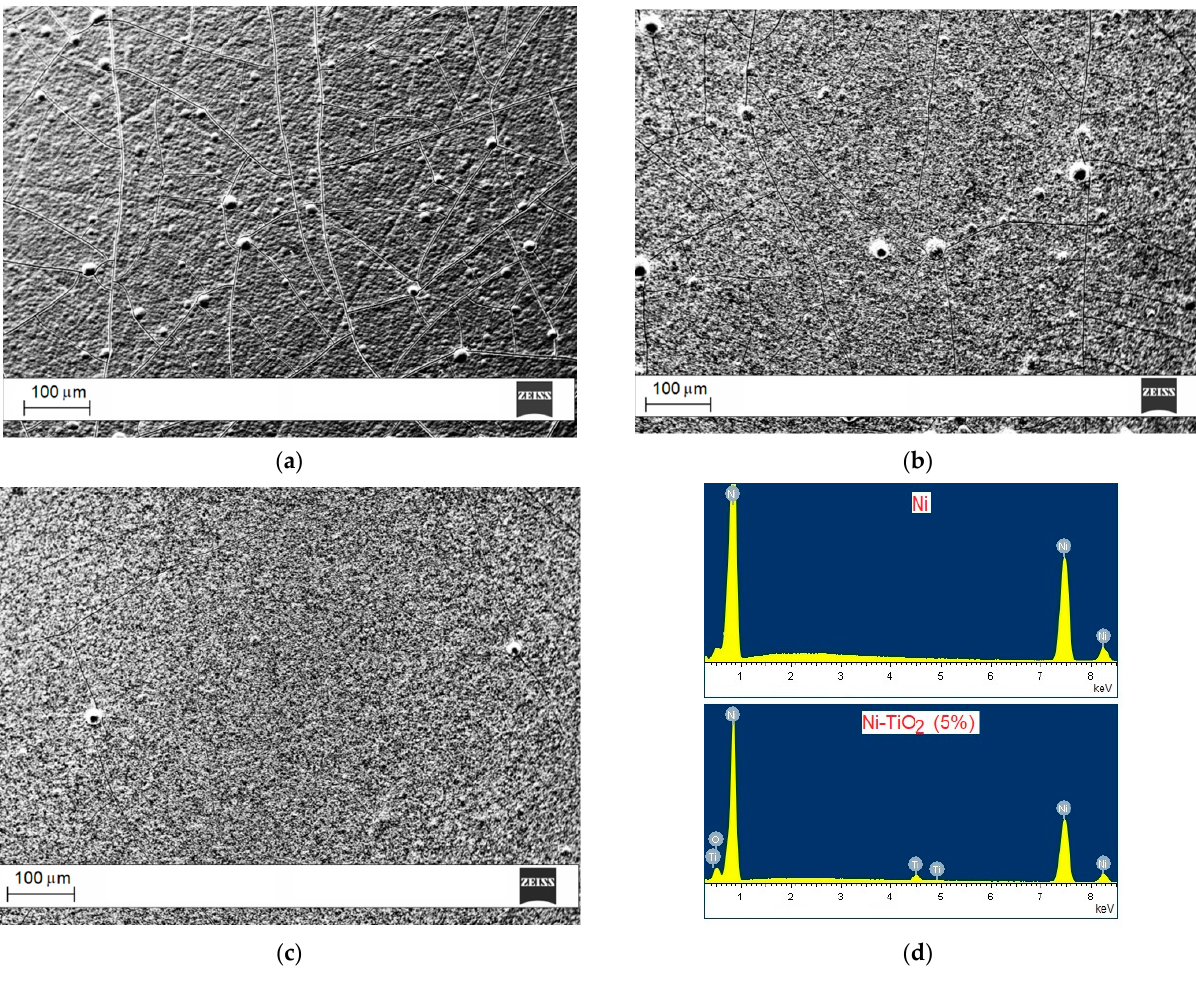
Figure 2. ( a – c ) SEM microphotographs of coatings electrodeposited from electrolytes based on ethaline: ( a ) Ni, ( b ) Ni–TiO 2 (5%) and ( c ) Ni–TiO 2 (10%); ( d ) typical EDX spectra of Ni and Ni– TiO 2 (5%) coatings.